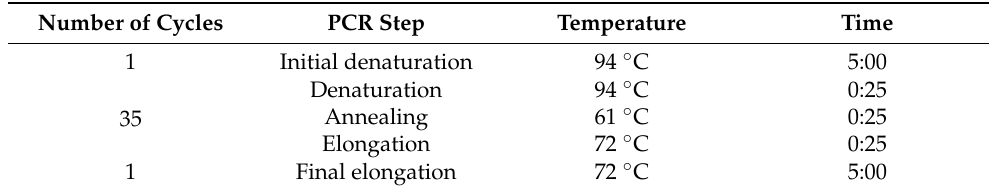
Table 2. PCR reaction conditions for the amplification of a 447 bp fragment encompassing 33 CpG sites in the promoter of the DAT1